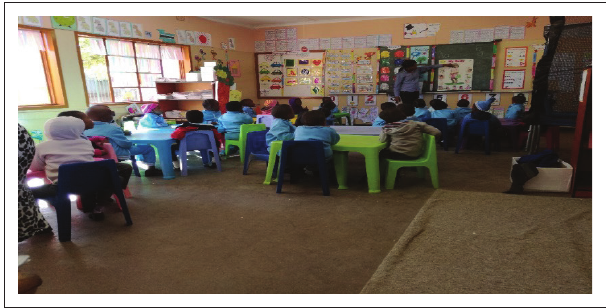
FIGURE 1 : Sample of classroom